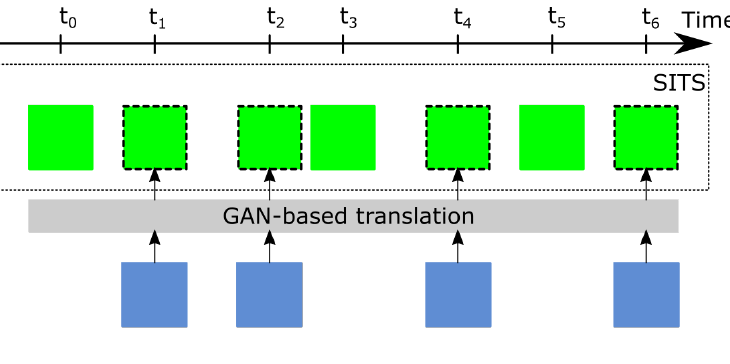
Figure 1. Methodology overview for multi-source SITS analysis. The images with a dashed border represent the corresponding GAN-based translations of images from the second